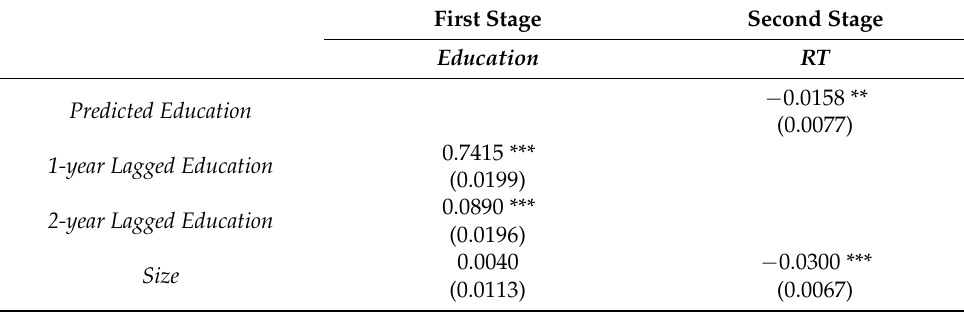
Table 9. Two-stage least